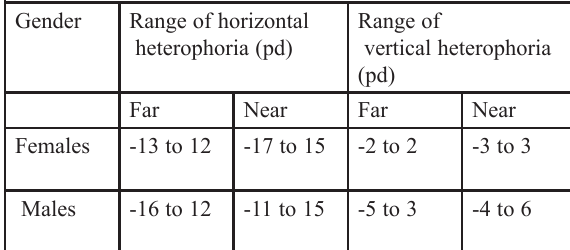
Table 2. A summary of heterophoria values according to gender for distance and near vision. Positive values refer to exophoria and right hyperphoria while negative refer to eso- phoria and right hypophoria. The units are in prism diopters